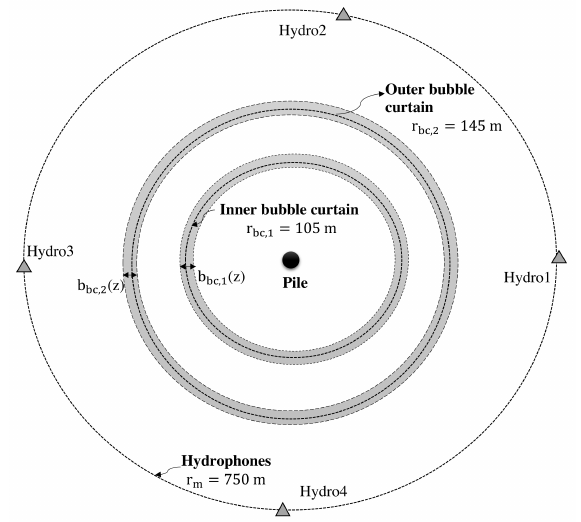
Figure 9. Layout of double air bubble curtains (DBBC)